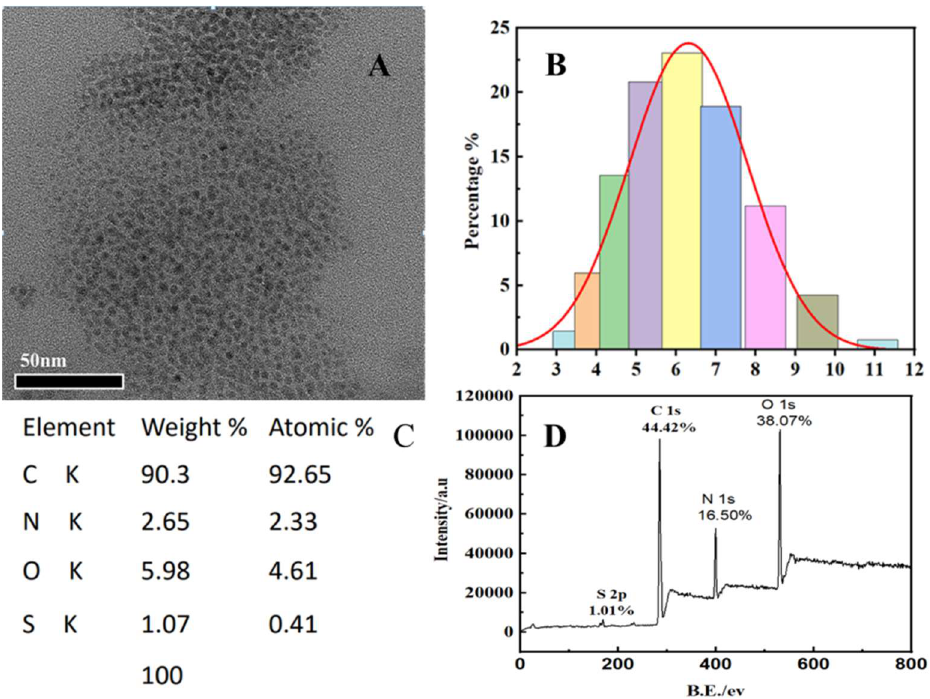
Figure 1. ( A ) HRTEM image of the synthesized S, N-CQDs; ( B ) S, N-CQDs particle size distribution; ( C ) Element composition of S, N-CQDs; ( D ) XPS of S, N-CQDs.